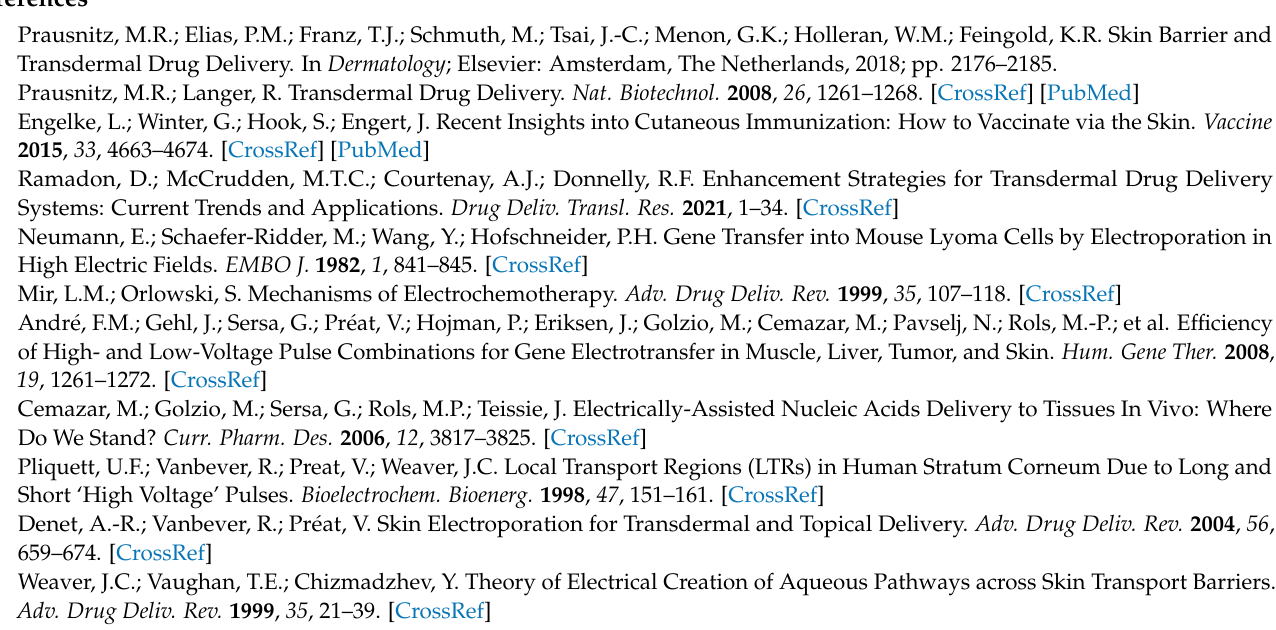
cell death upon EP treatment; Figure S3: Comparison of the natural uptake of the three FD4 derivates; Figure S4: Effect of bipolar pulses on